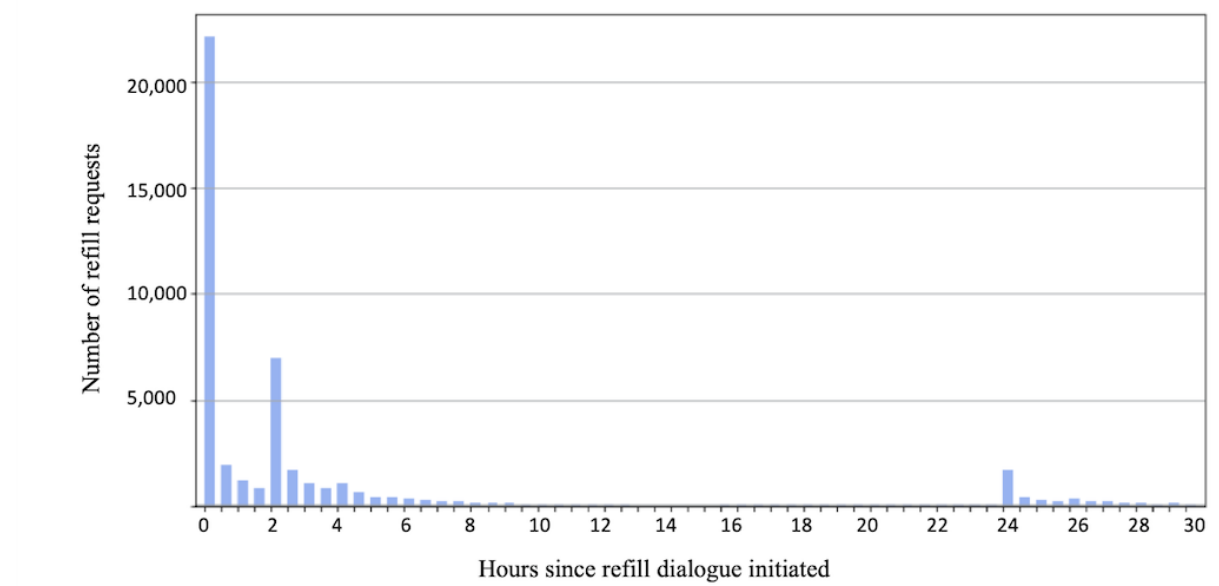
Figure 3. Refills requests by hour from initial reminder.